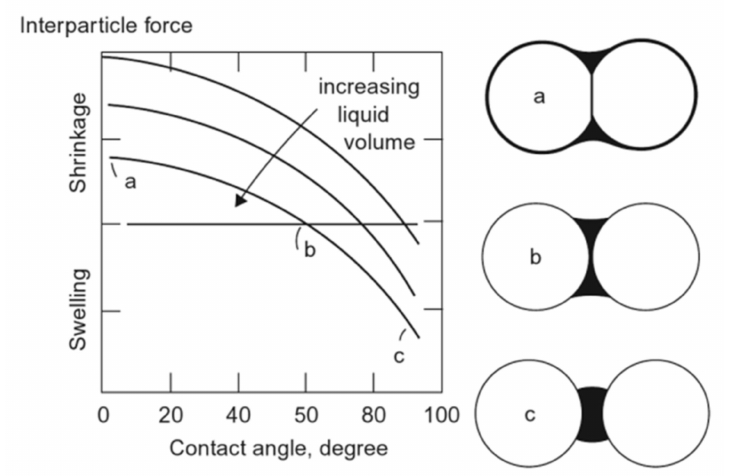
Figure 4. Relationship between wettability and densification capacity in a solid-liquid system: ( a ) represents excellent wettability and ( c ) lack of wettability, ( b ) is an intermediate stage. After